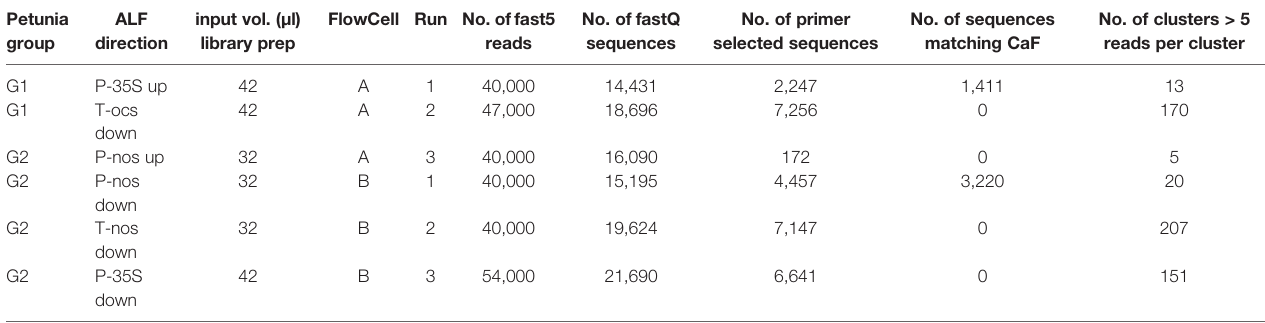
TABLE 3 | MinION sequencing data